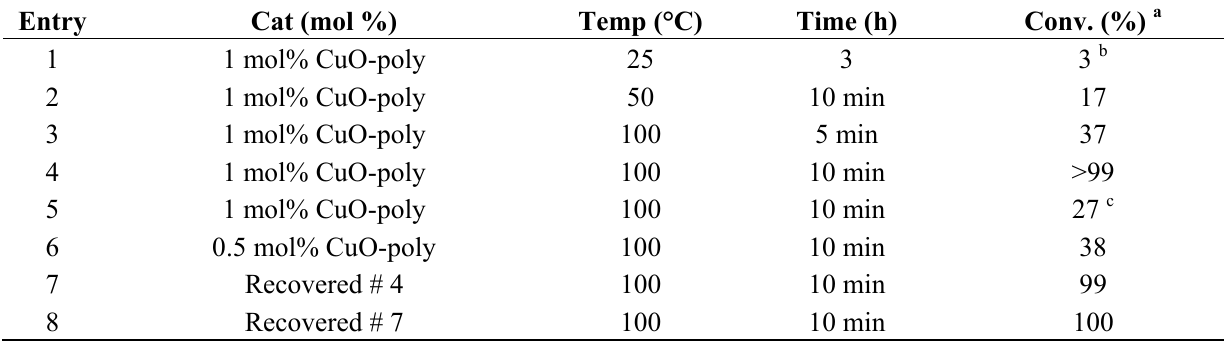
Table 5. Optimization of the click reaction catalyzed by water-soluble CuO nanoparticle. Entry Cat (mol %) Temp (°C) Time (h) Conv. (%)